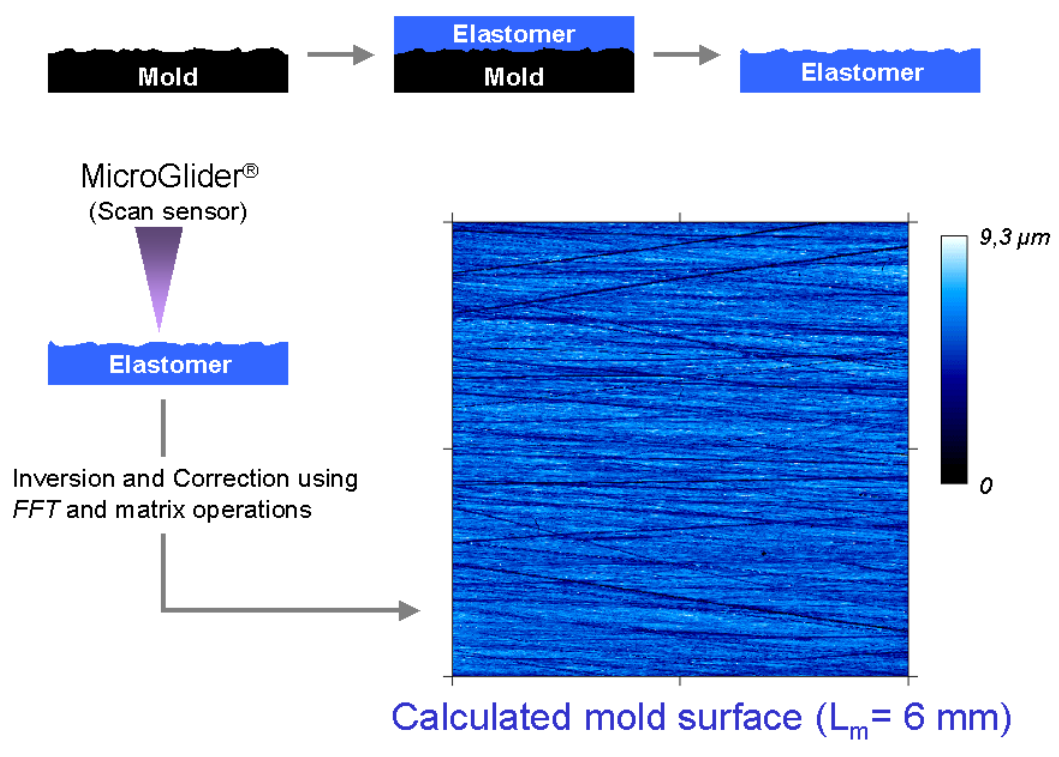
Figure 11. Indirect calculation of mould topography by transfer in silicon elastomer.